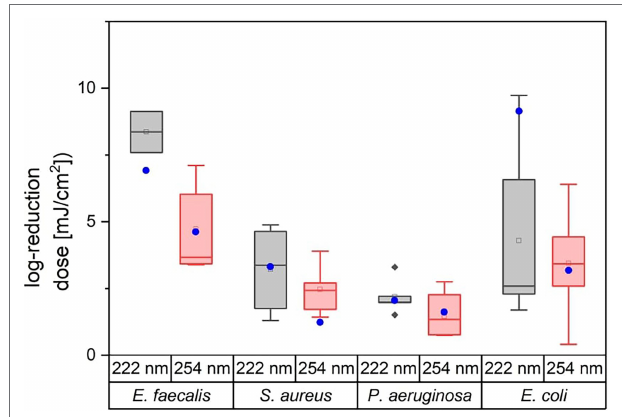
FIGURE 3 | Overview of literature values for average log reduction doses of E. faecalis , S. aureus , P. aeruginosa , and E. coli . The attached blue circular dots represent the average log reduction doses of the investigated non-pathogenic relative. The corresponding data can be found in Table 2 .